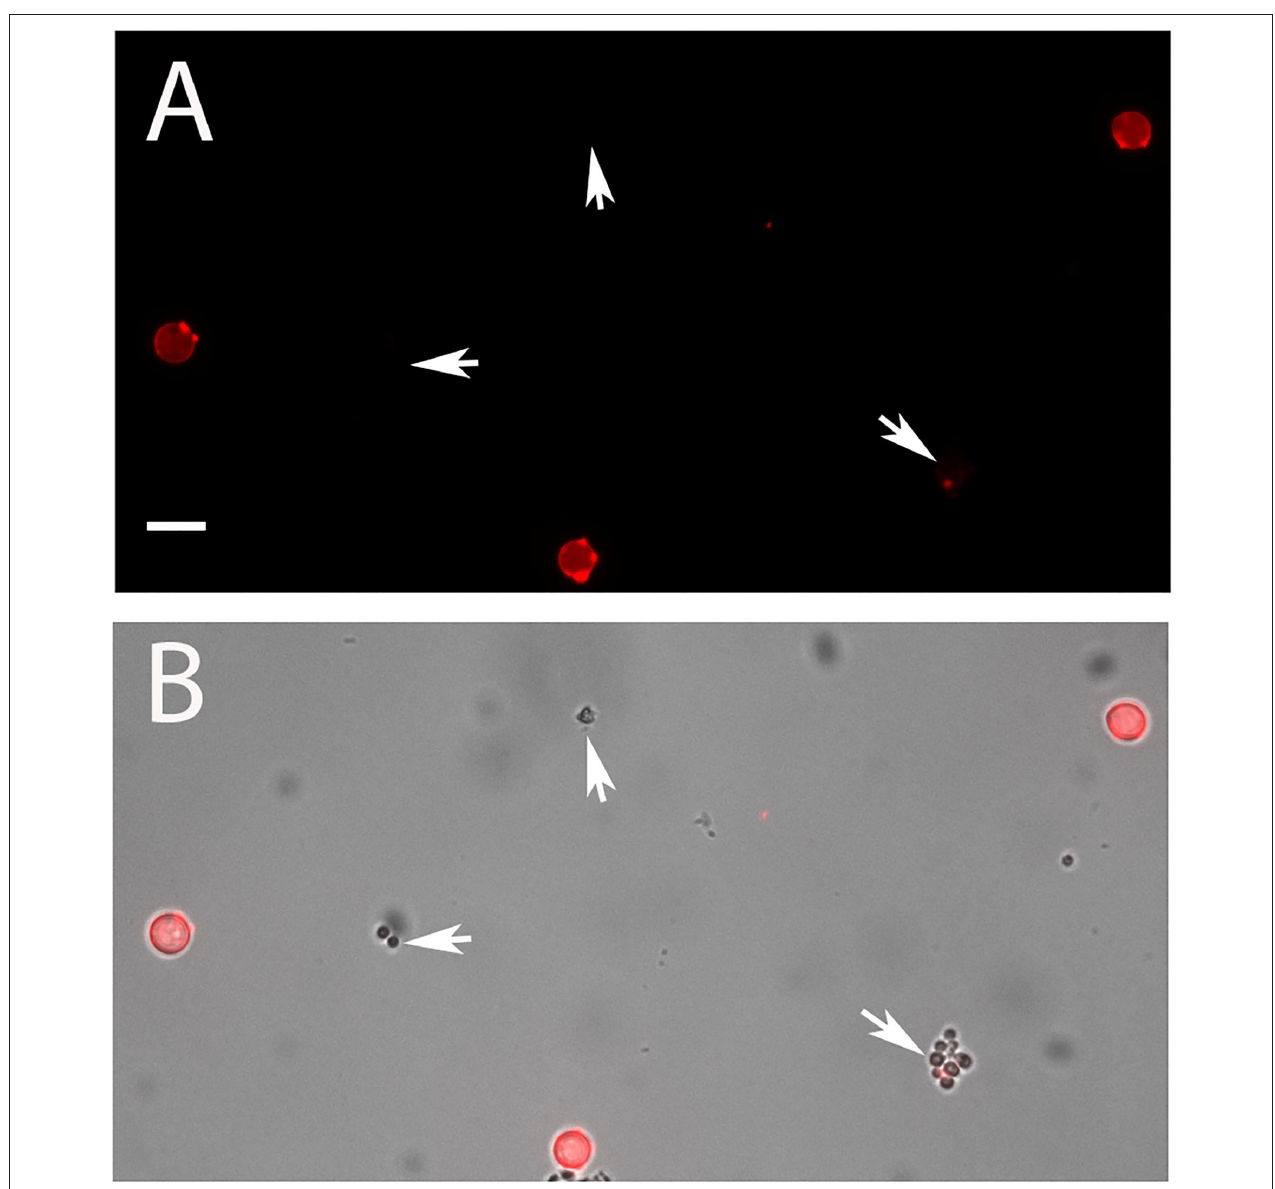
FIGURE 3 | AC and PC of strain At17-14 were stained in red with the galactomannan-specific antibody L10-1. (B) shows the overlay of a galactomannan staining and the corresponding bright field image. PC are indicated by arrows. The bar in (A) represents 5 µ m and is valid for all